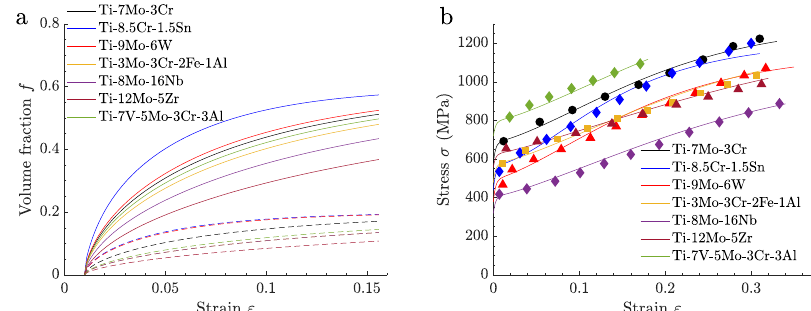
Fig. 4 Model validation to multiple TRIP/TWIP alloys. a The predicted evolution of twin volume fraction f tw (solid curves) and α ″ volume fraction f α ″ (dash curves) in Ti-7Mo-3Cr, Ti-8.5Cr-1.5Sn, Ti-9Mo-6W, Ti-3Mo-3Cr-2Fe-1Al, Ti-8Mo-16Nb, Ti-12Mo-5Zr and Ti-7V-5Mo-3Cr-3Al alloys. b The modelled fl ow stresses reasonably well agree to the experimental data. Table 2. Material variables of the tested TRIP/TWIP Ti alloys.